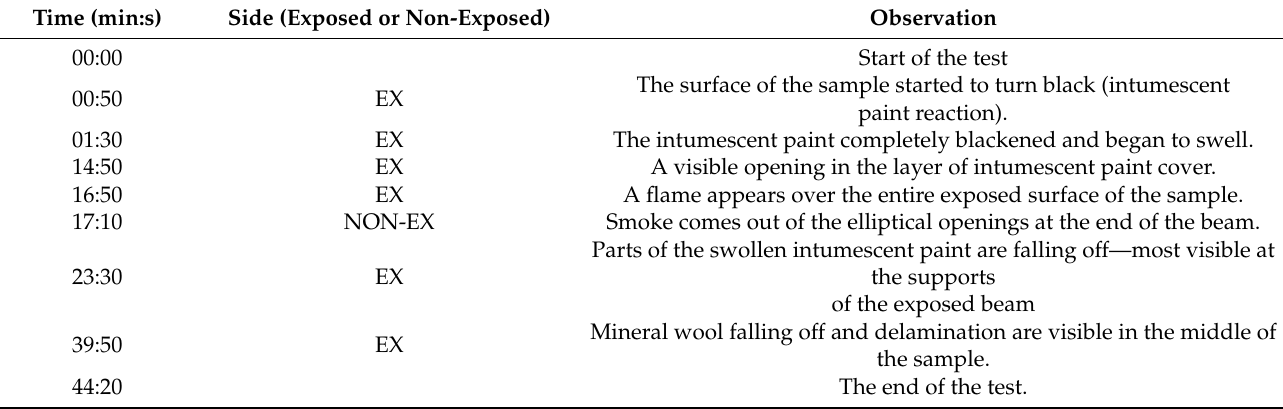
the supports of the exposed beam Mineral wool falling off and delamination are visible in the middle of the sample. The end of the